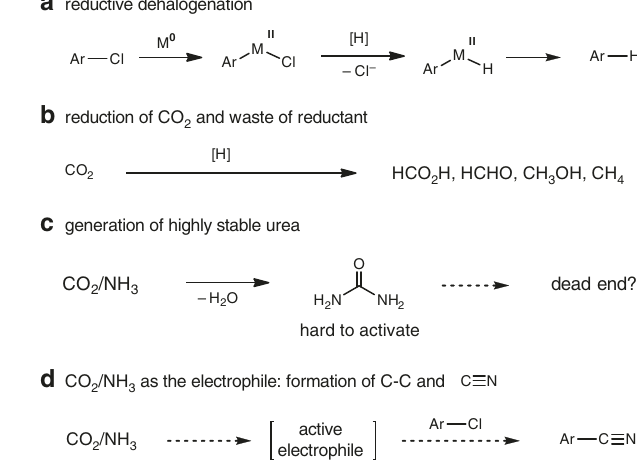
Fig. 1 Catalytic cyanations with different cyano sources. a The use of metal cyanides, b organic cyano compounds, and c CO 2 /NH 3 as the CN source.